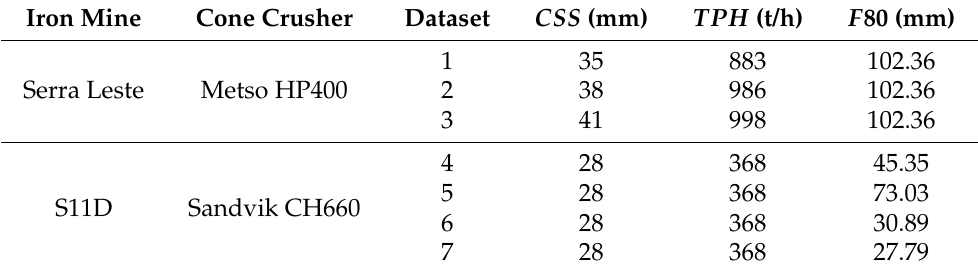
Table 1. Summary of plant name, cone crusher type and operating parameters for each